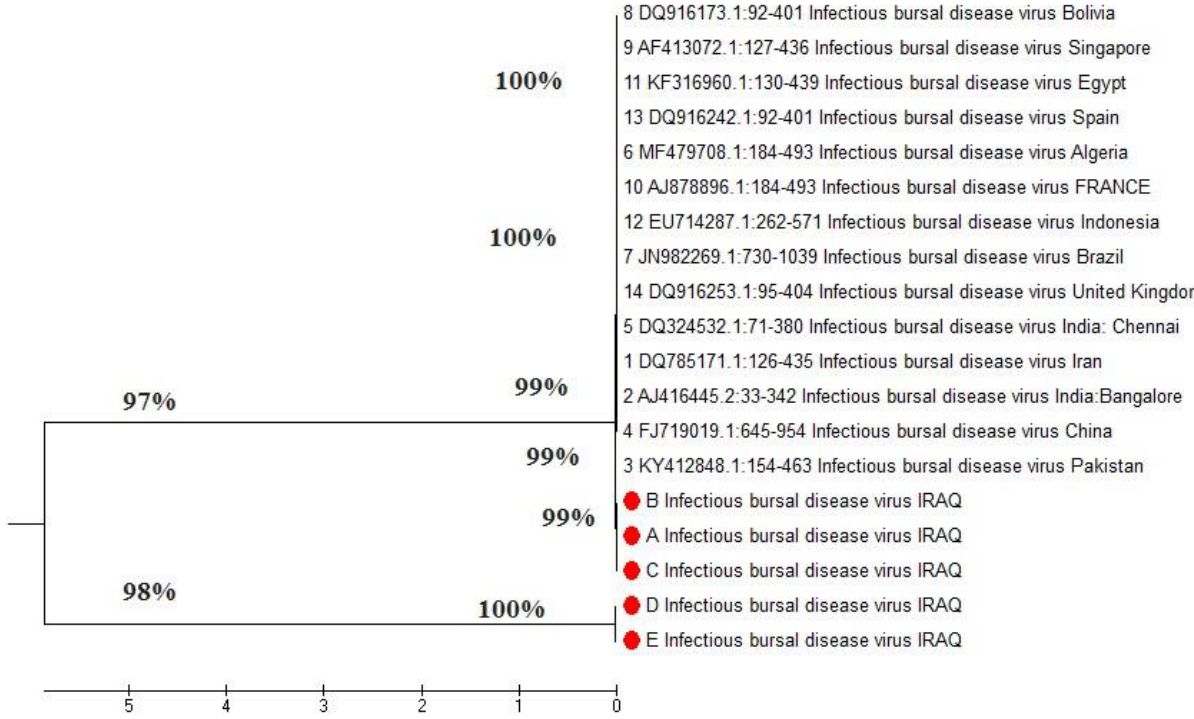
Figure 3. Phylogenetic tree of partial fragment of the VP2 gene of five Iraqi field isolates of IBDV from the clinical samples compared with globally published IBDV strains. Branched distances correspond to sequence divergence. Accession numbers of the